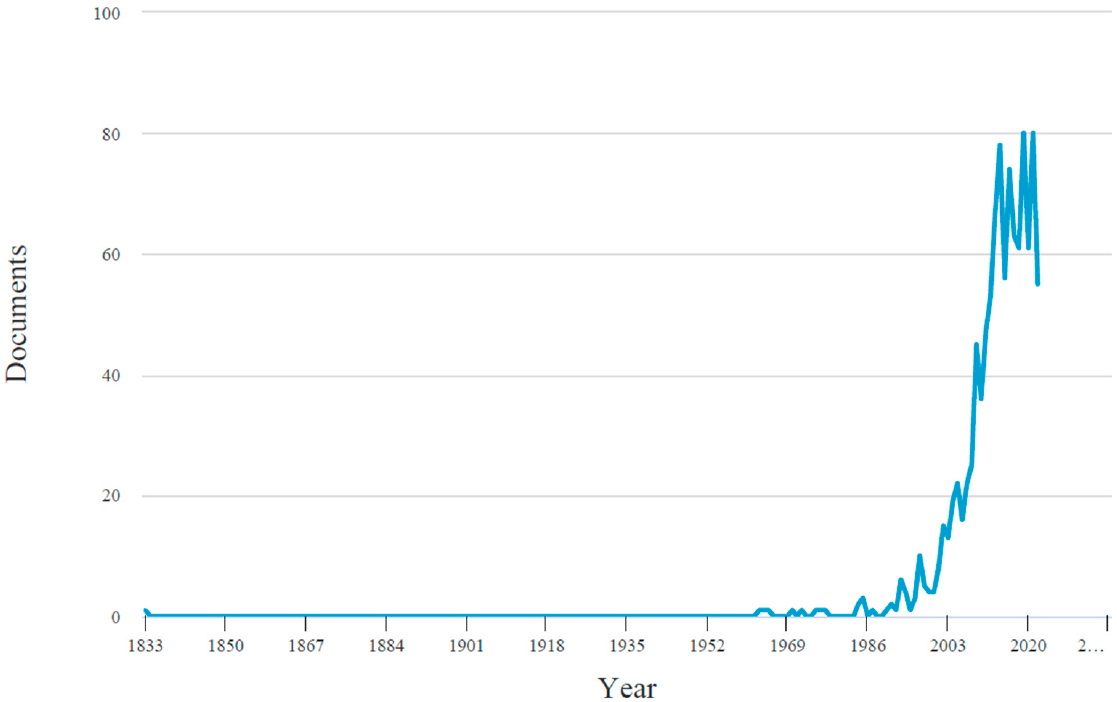
Figure 1. Expatriation documents by year. Source: Data obtained from Scopus (August 2022).